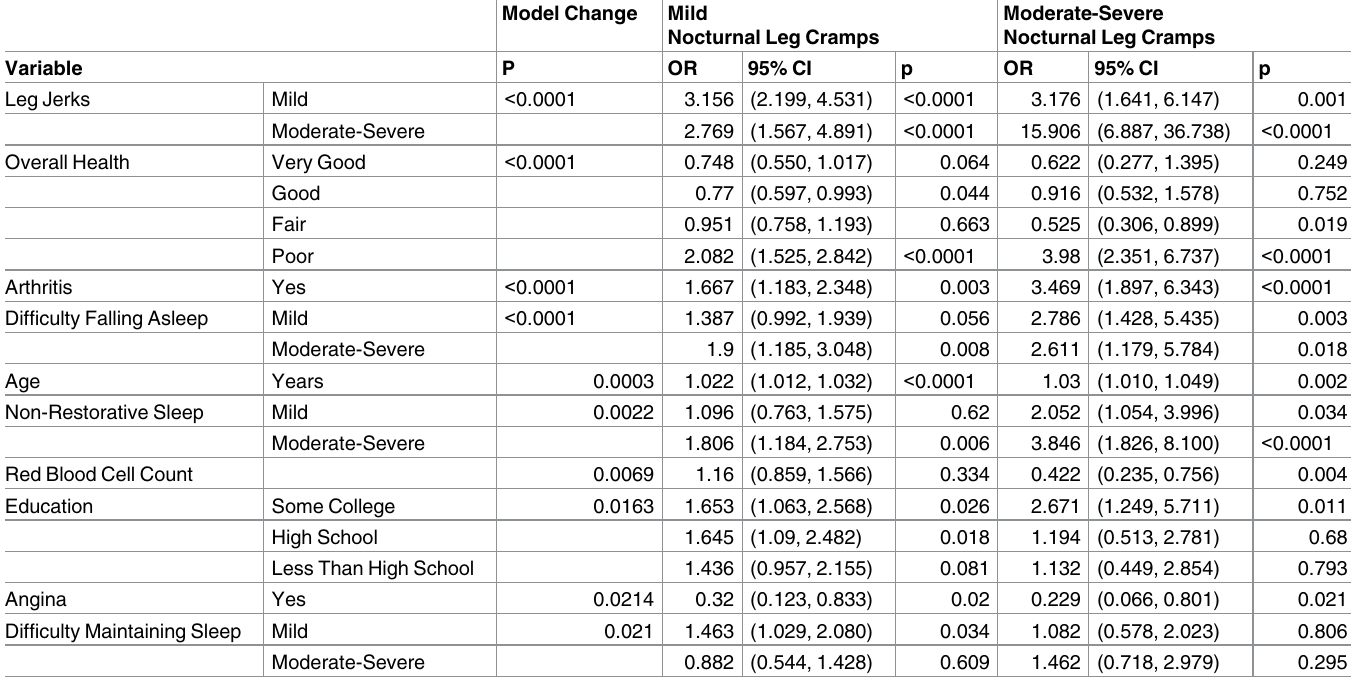
Table 4. Stepwise logistic regression results of associations between nocturnal leg cramps and all significant factors (combined